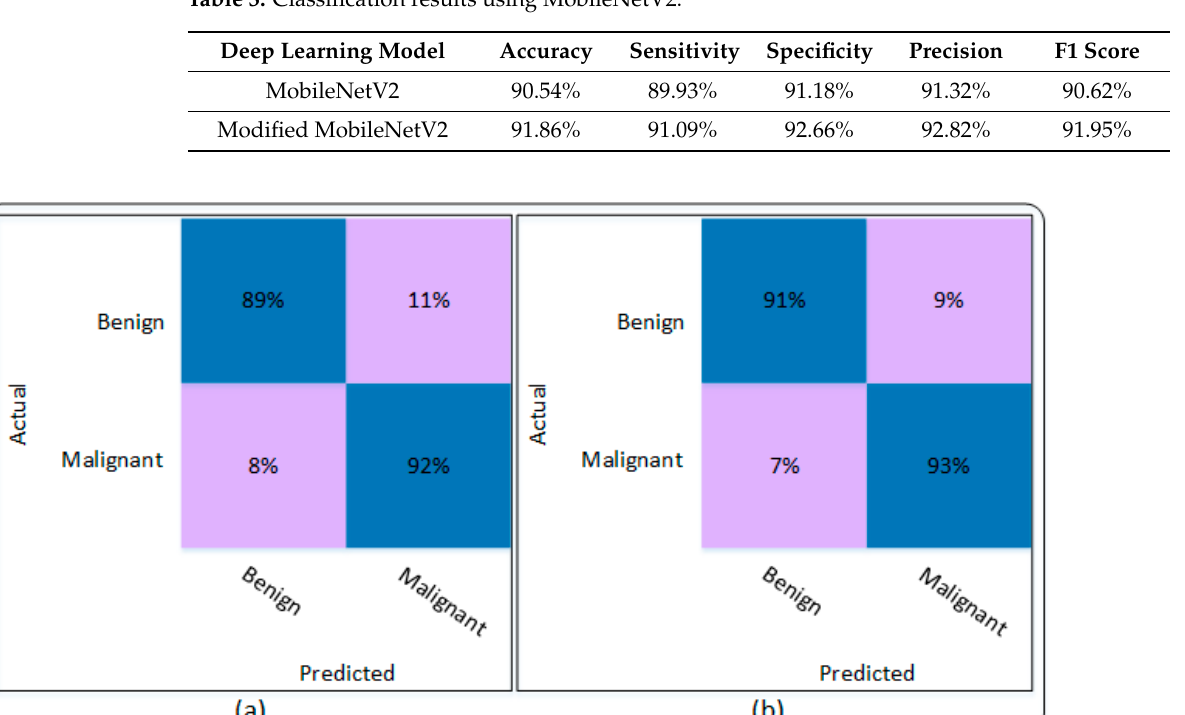
Table 3. Classification results using MobileNetV2.